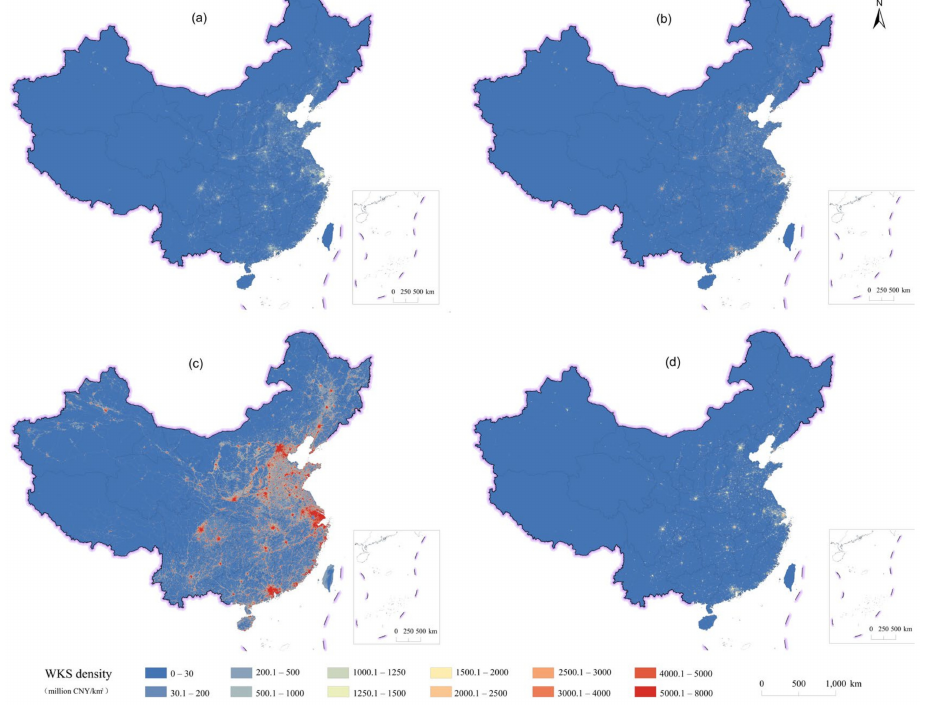
Figure 3. Gridded WKS maps in 2012 by using ( a ) RF, ( b ) cubist, ( c ) XGBoost, and ( d ) stacking